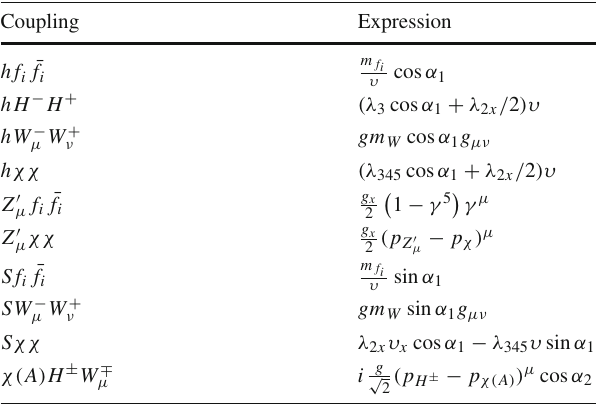
¯ x ¯ x , where x ¯ x = b b , τ − τ + , μ − μ + , W W ∗ , Z Z ∗ , γ γ